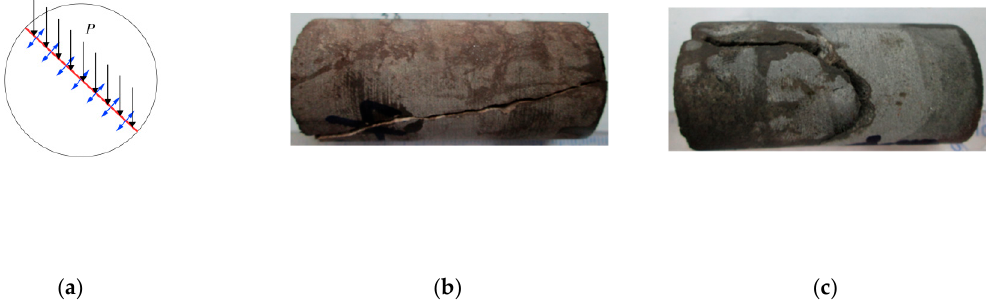
Figure 2. ( a ) A sketch of the fracture-forming method in cores with different penetration extents. The red line is the alloy structure steel wire, the pressure represented by the black arrows is exerted directly on the wire in the normal direction of the upper plate of the core, and the crack occurs along the direction of the blue arrows. ( b ) A fully penetrated core and ( c ) partly penetrated core.